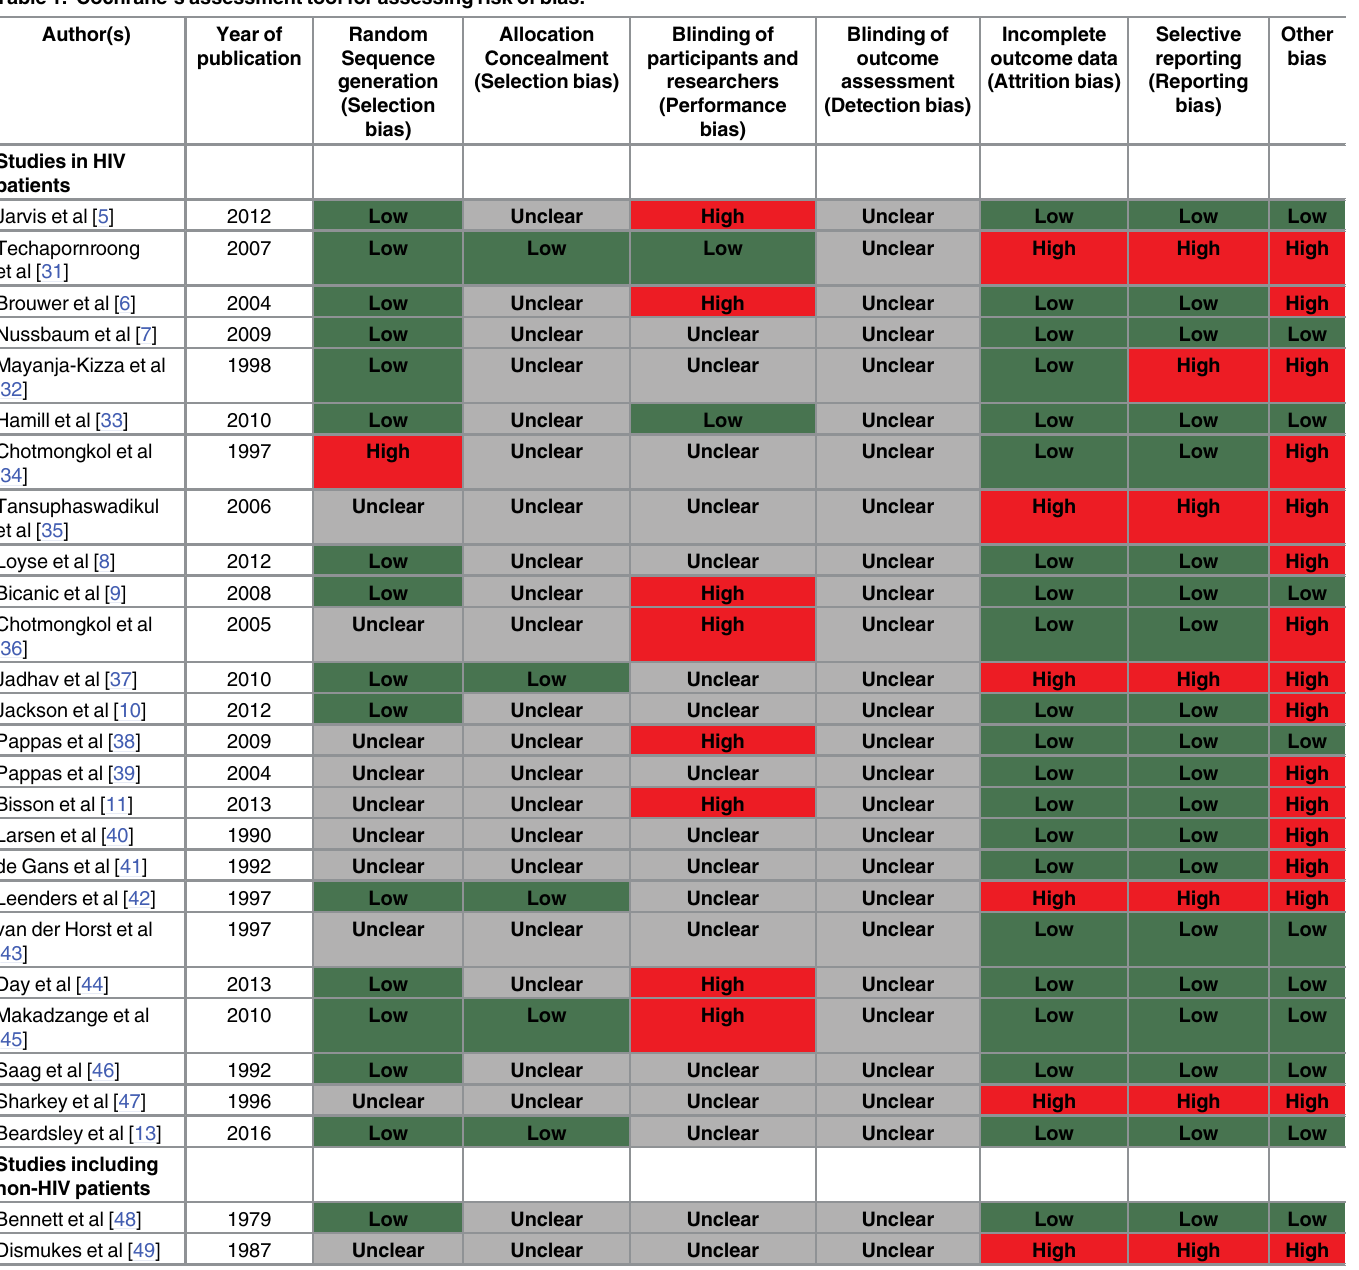
Table 1. Cochrane´s assessment tool for assessing risk of